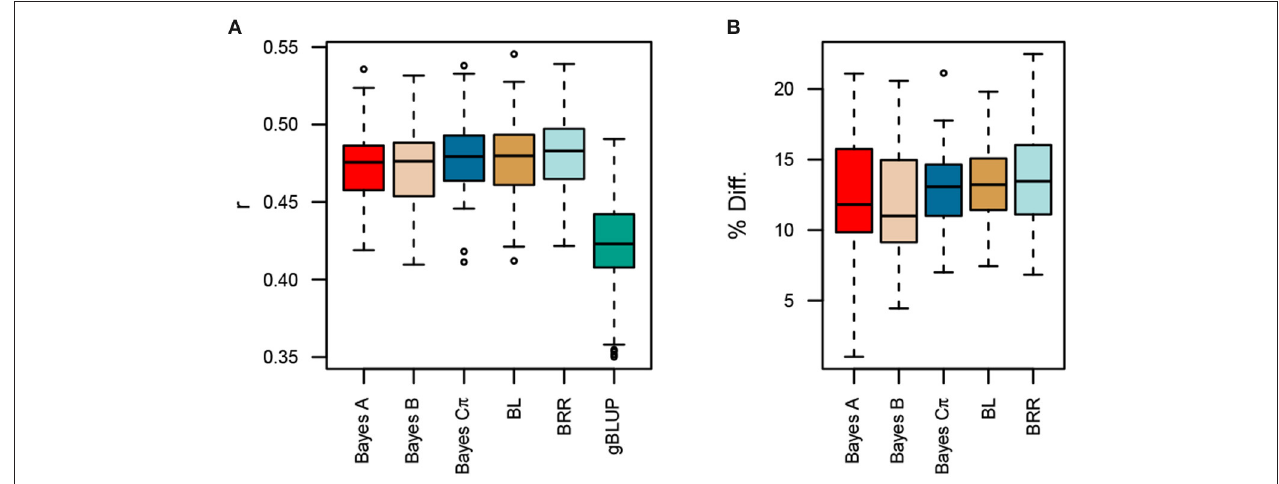
FIGURE 3 | Comparison of prediction accuracies for multi-kernel trait-specific BLUP models (MK-TGRM-BLUP) and a genomic BLUP approach (gBLUP). The multi-kernel models used TGRMs constructed from estimated marker effects for the nine fatty acid traits. Prediction accuracy was assessed using five-fold cross validation with 50 resampling runs. The correlation between predicted genomic breeding values in the testing population and the observed phenotypes at each location is shown in (A) . Panel (B) shows the percent improvement relative to gBLUP for each MK-TGRM-BLUP approach. BL, Bayesian LASSO; BRR, Bayesian ridge regression; r , Pearson’s correlation coefficient.